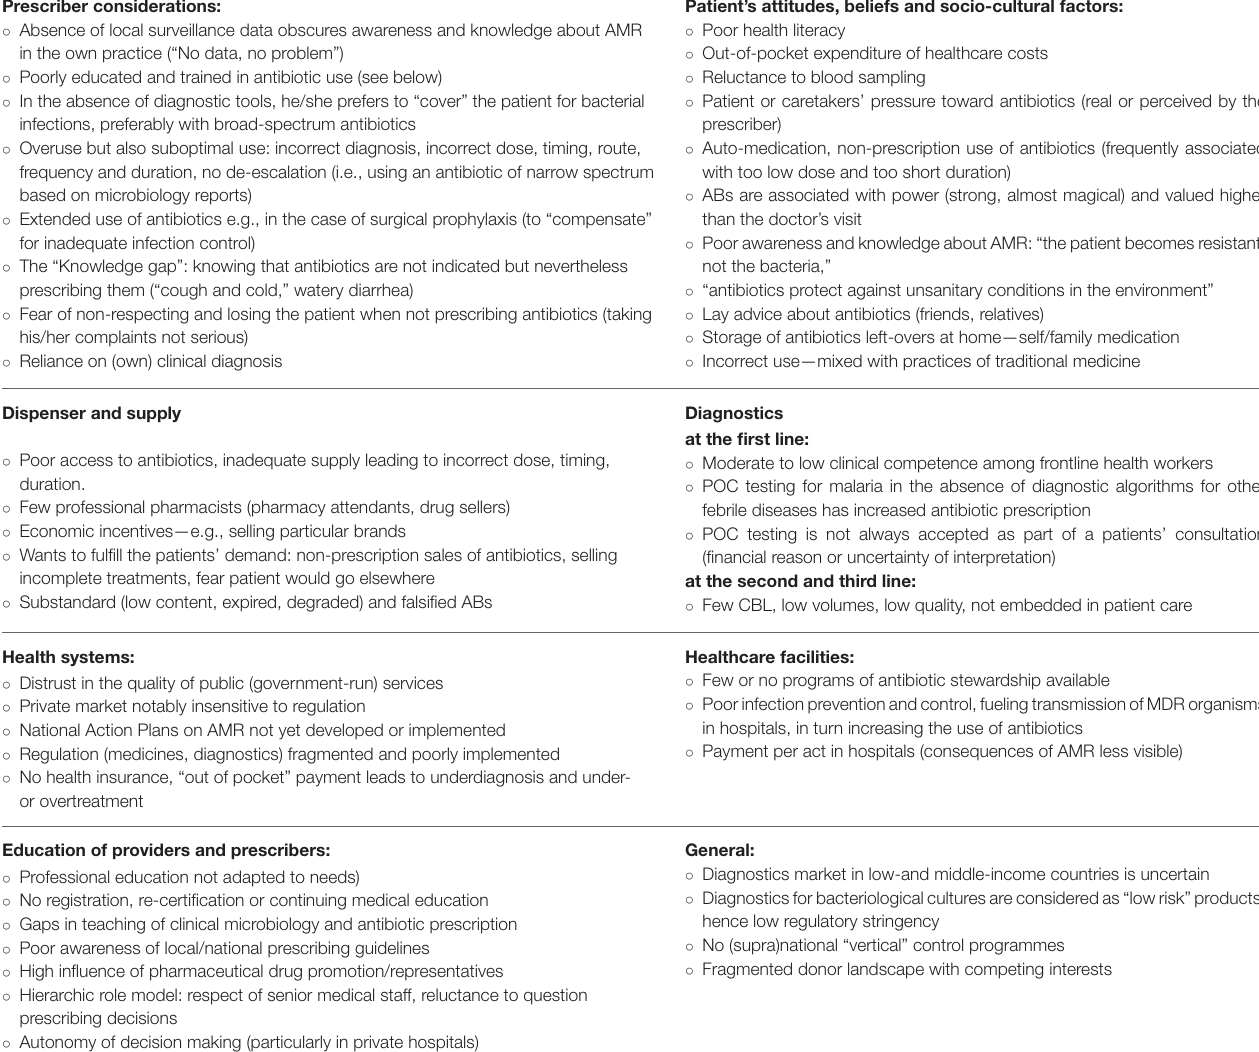
Patient’s attitudes, beliefs and socio-cultural factors: ◦ Poor health literacy ◦ Out-of-pocket expenditure of healthcare costs ◦ Reluctance to blood sampling ◦ Patient or caretakers’ pressure toward antibiotics (real or perceived by the prescriber) ◦ ABs are associated with power (strong, almost magical) and valued higher than the doctor’s visit ◦ Storage of antibiotics left-overs at home—self/family medication ◦ Incorrect use—mixed with practices of traditional medicine